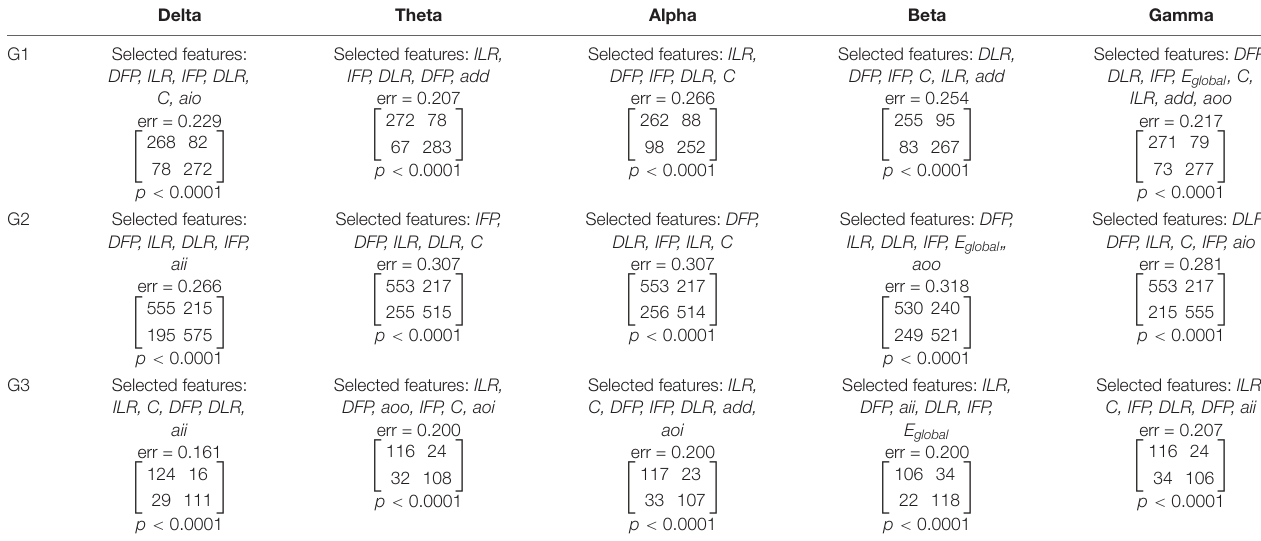
TABLE 3 | The results of feature selection and classification by condition (i.e., before and after TMS) performed separately for each of the three stimulation protocols and five frequency bands. Delta Theta Alpha Beta Gamma